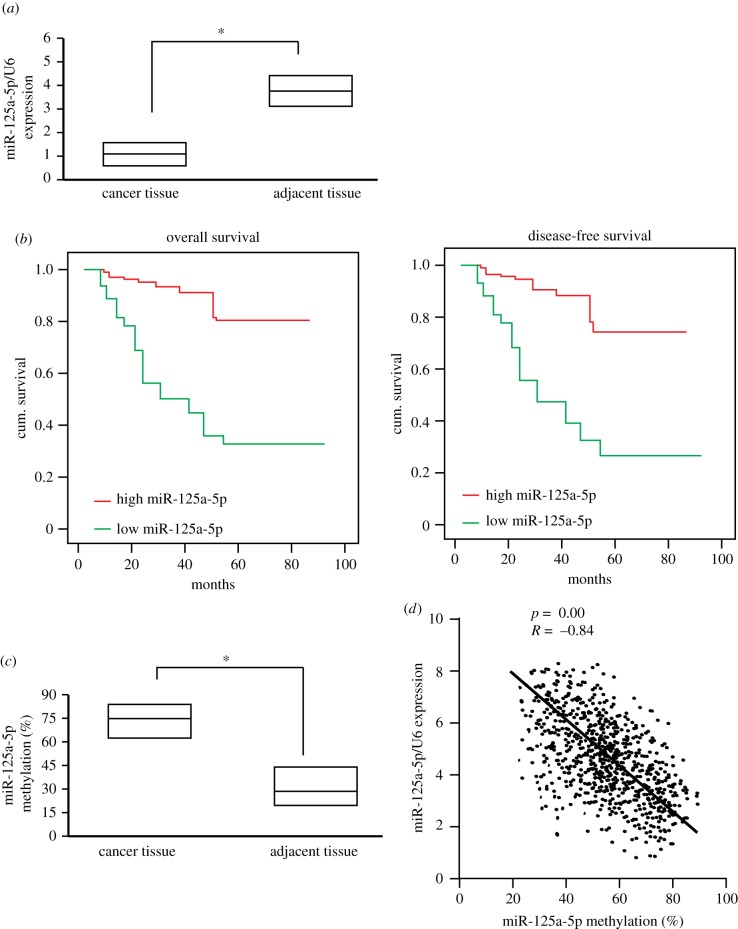
Reduced miR-125a-5p is correlated with the poor prognosis of NSCLC. (a) miR-125a-5p levels in cancer tissues and adjacent normal tissues were determined by qPCR (n = 384). The middle line indicates median; bottom of box, 25th percentile; top of box, 75th percentile. *p < 0.05. (b) Kaplan–Meier survival curve of patients with high or low level of miR-125a-5p. (c) miR-125a-5p methylation levels in cancer tissues and adjacent normal tissues were determined (n = 384). The middle line indicates median; bottom of box, 25th percentile; top of box, 75th percentile. *p < 0.05. (d) Correlation between the mRNA level and the methylation level of miR-125a-5p.